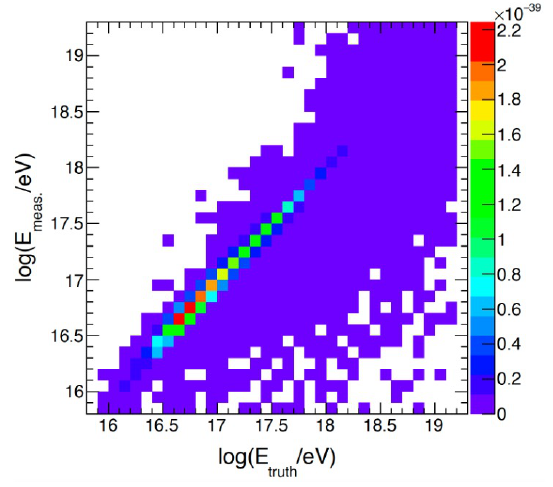
Figure 2. Resolution map between true and measured energies. The resolution map is evaluated by the MC simulation.